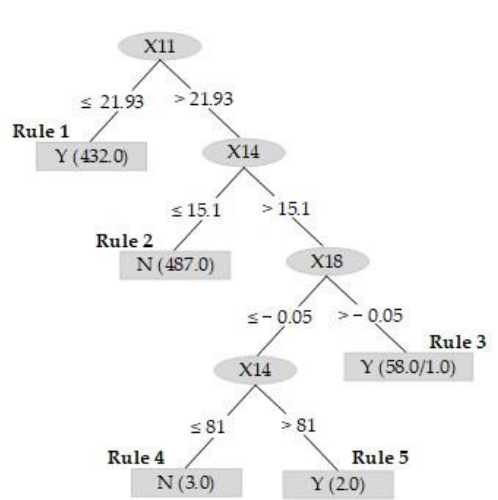
Figure 2. Feature selection DT for 491 normal and 491 bankrupt companies (1:1).